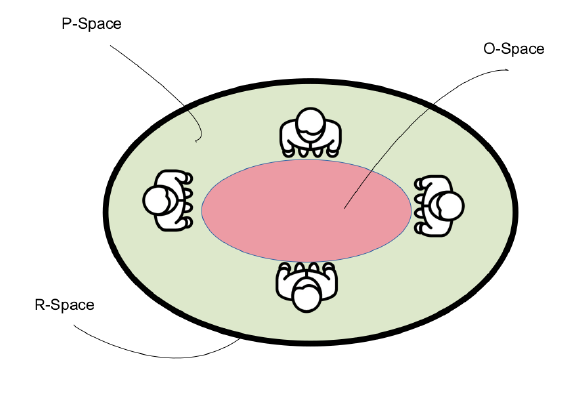
Figure 12. Representation of the different parts of the space for a group of